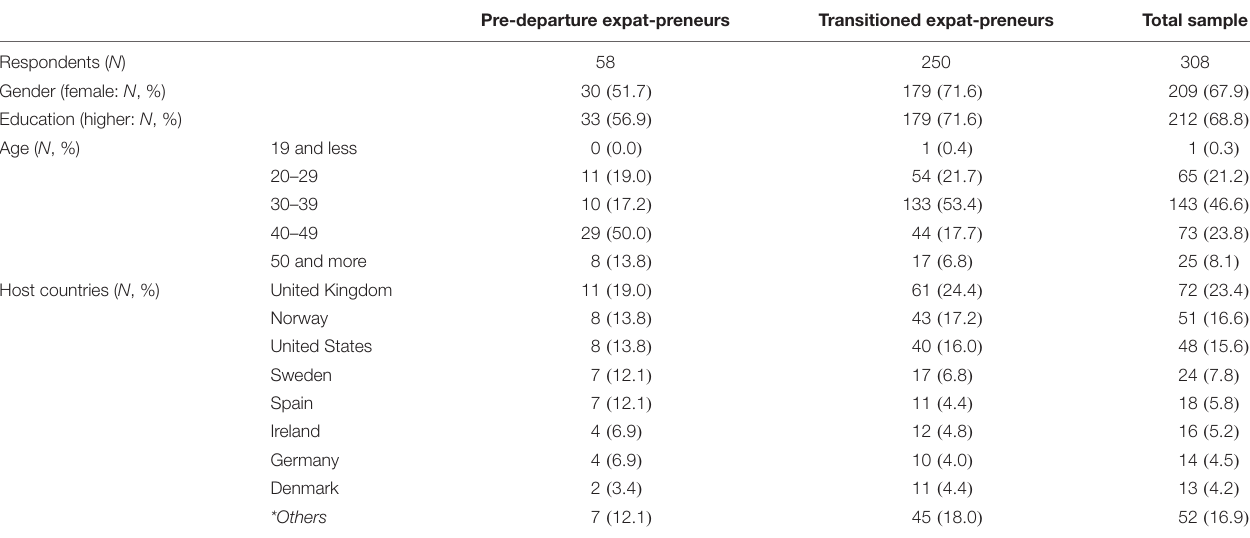
TABLE 2 | Demographic characteristics of the